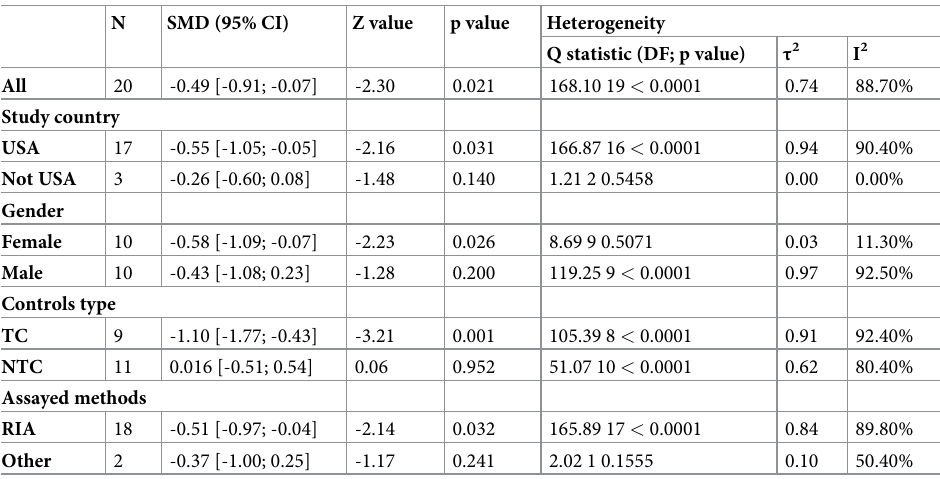
Table 2. Subgroup